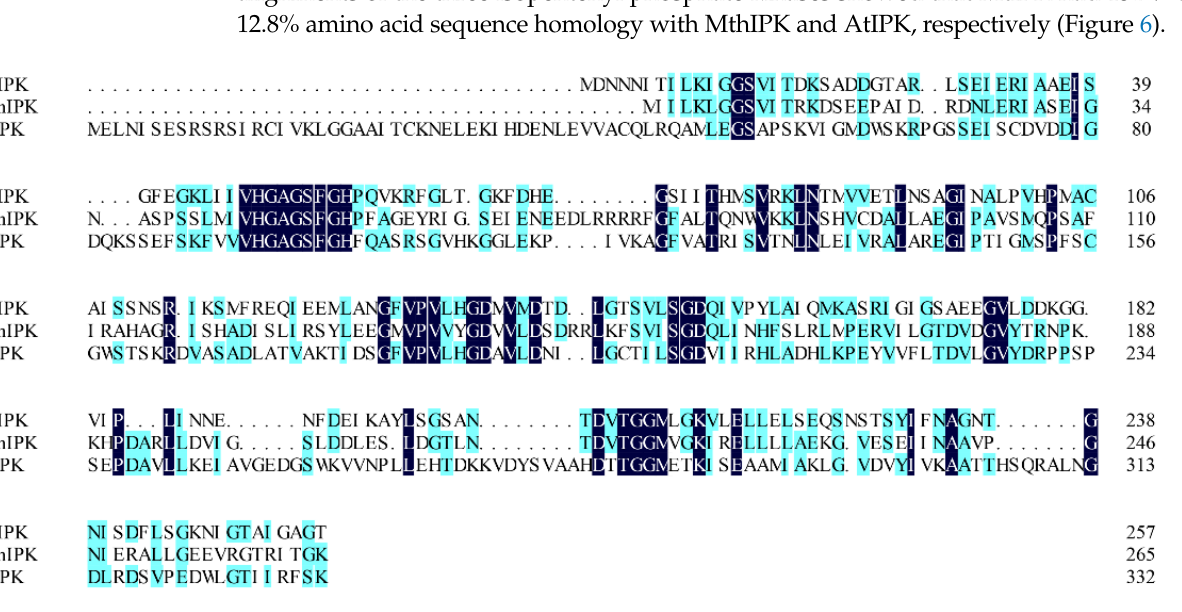
Figure 7. SDS – PAGE analysis of recombinant isopentenyl phosphate kinases in E. coli : ( A ) SDS – PAGE analysis of MtIPK (lane M: protein marker; lane 1: the total protein of BL21(DE3); lane 2: the soluble protein in BL21(DE3); lane 3: the total protein of BL2-MtIPK; lane 4: the soluble protein in BL21-MtIPK; lane 5: purified MtIPK). ( B ) SDS – PAGE analysis of MthIPK (lane M: protein marker;